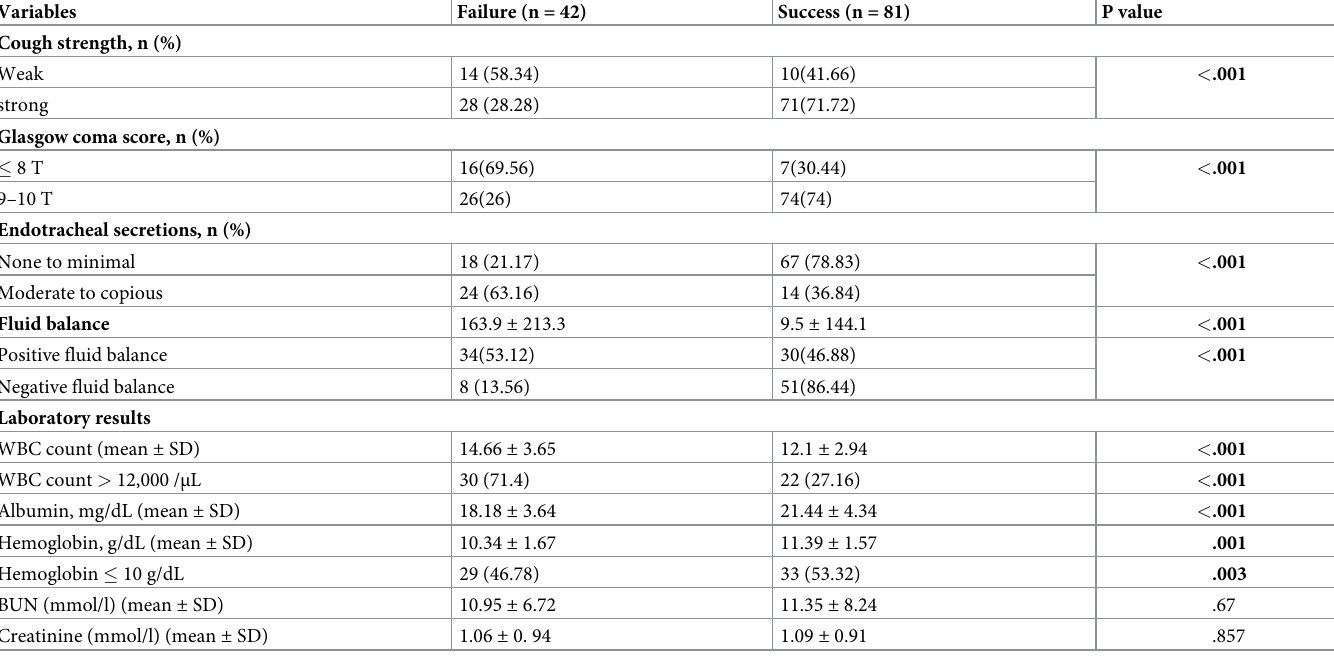
Table 2. Clinical profiles before the last spontaneous breathing trial between extubation success and extubation failure groups.